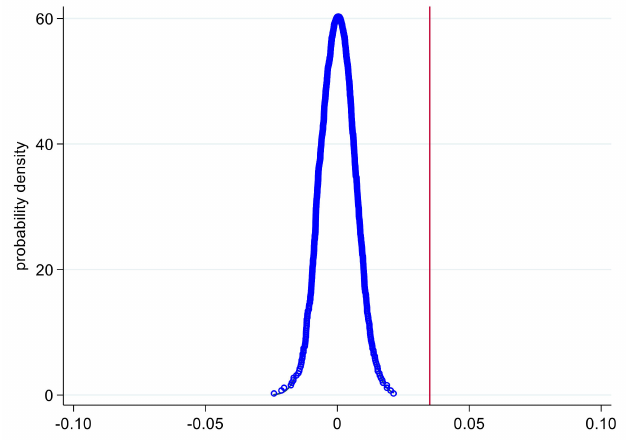
Figure 2. Placebo